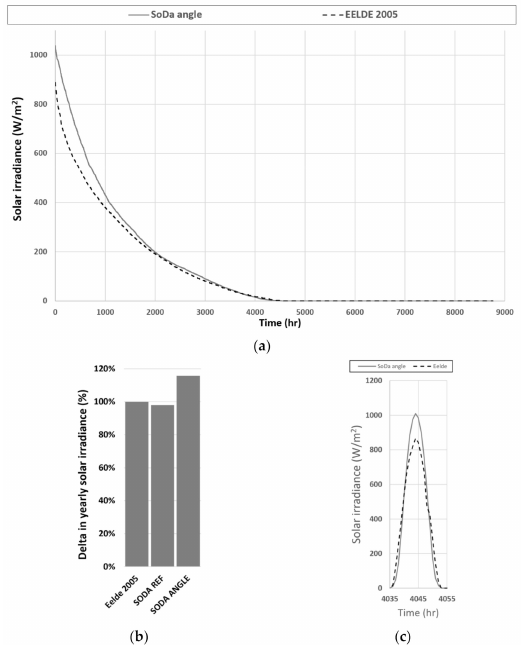
Figure A15. ( a ) LDC curve of measured flat solar irradiance at Eelde compared to corrected solar irradiance at angle of 30 degrees compiled by SoDa based on same Eelde data 2005 [70], ( b ) Difference in yearly irradiance 2005, ( c ) Solar irradiance of one summer day in